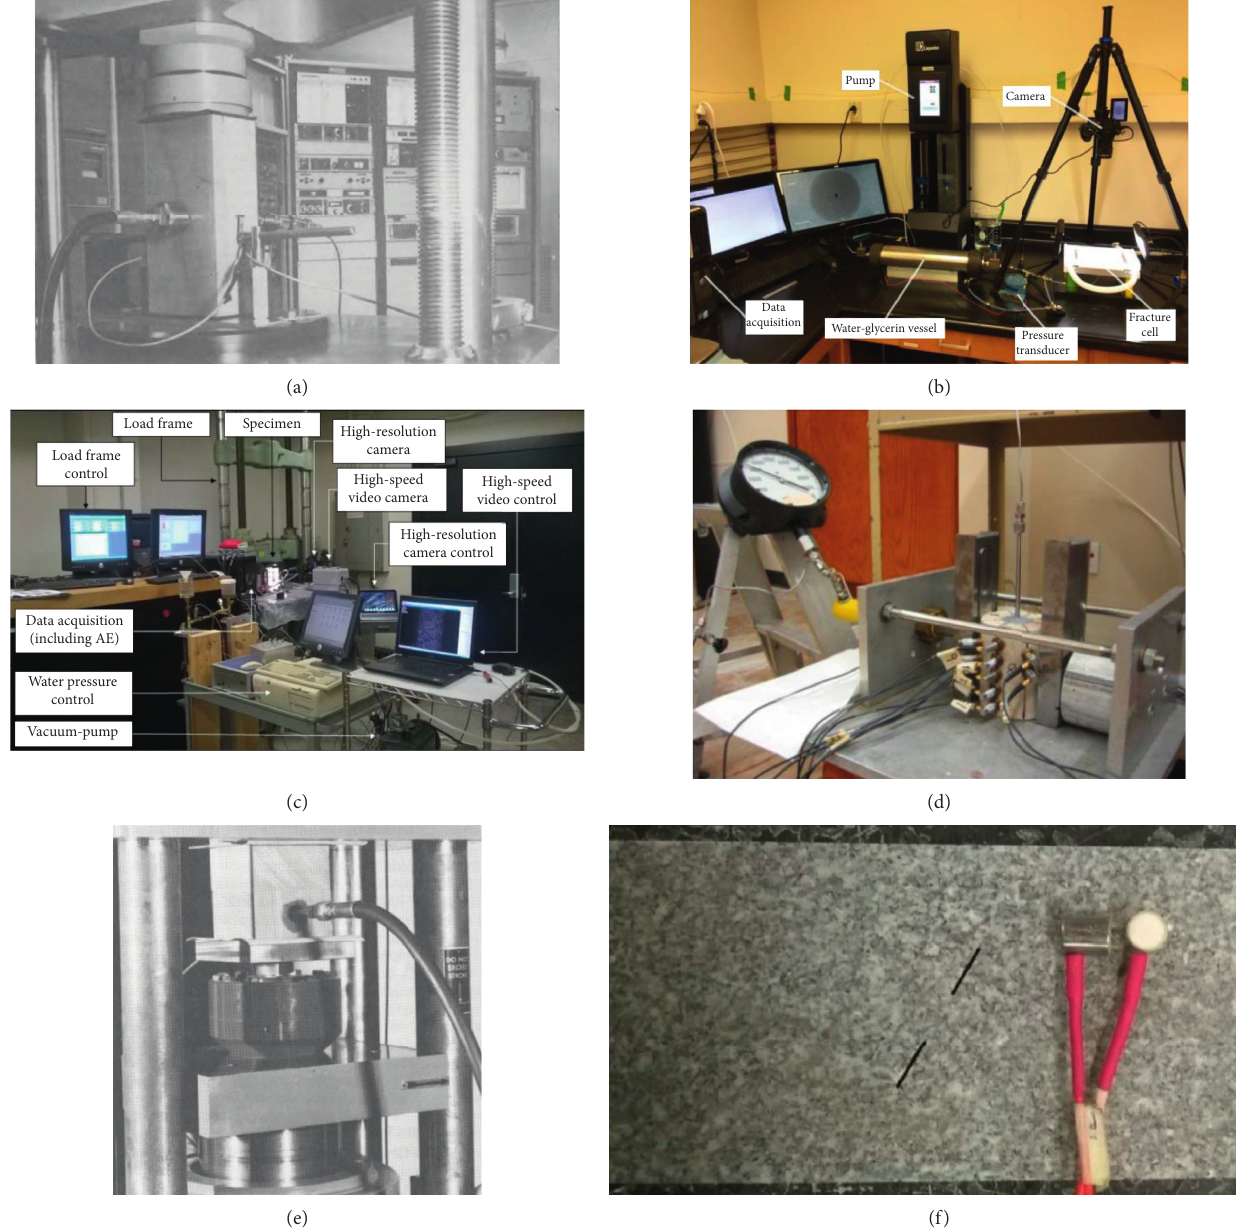
Figure 2: Uniaxial type setups for hydraulic fracturing experiments in (a) Daneshy [51]; (b) AlTammar et al. [10]; (c) Gonçalves da Silva et al. [53]; (d) Moreno et al. [56]; (e) Anderson [52]; and (f) Li et al.